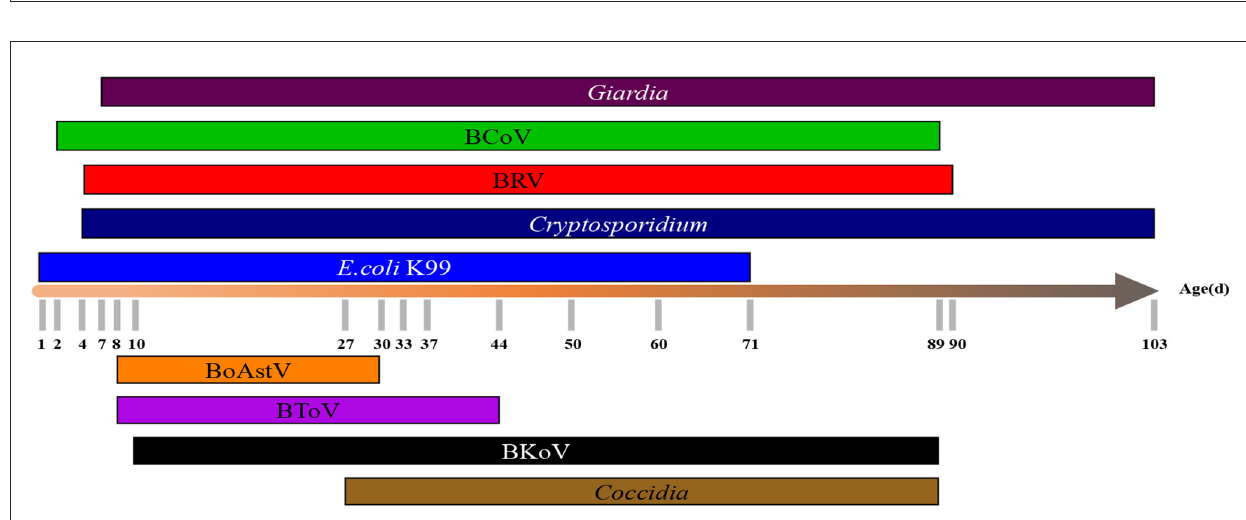
FIGURE6 The distribution of different pathogens in different ages. The distribution of 9 pathogens in calves of different ages (1–103 d) was counted.